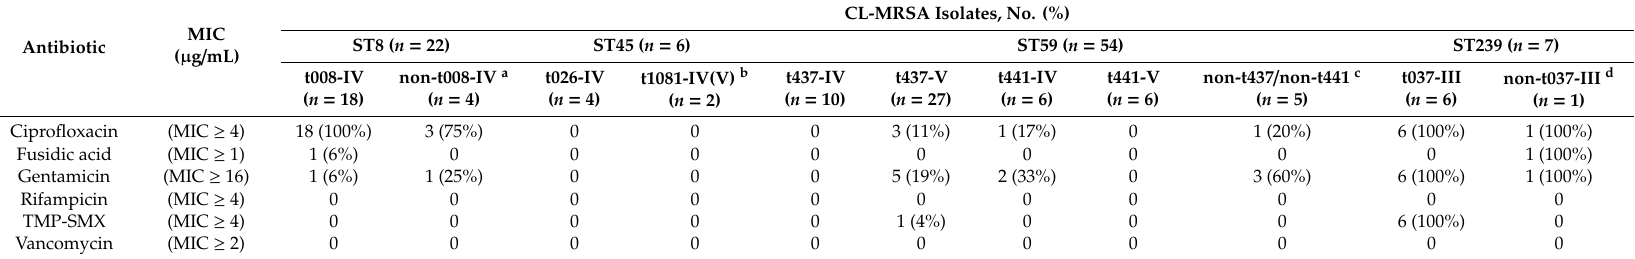
Table 6. Association between the antibiotic resistance profiles and the genotypes for CL-MRSA isolates.